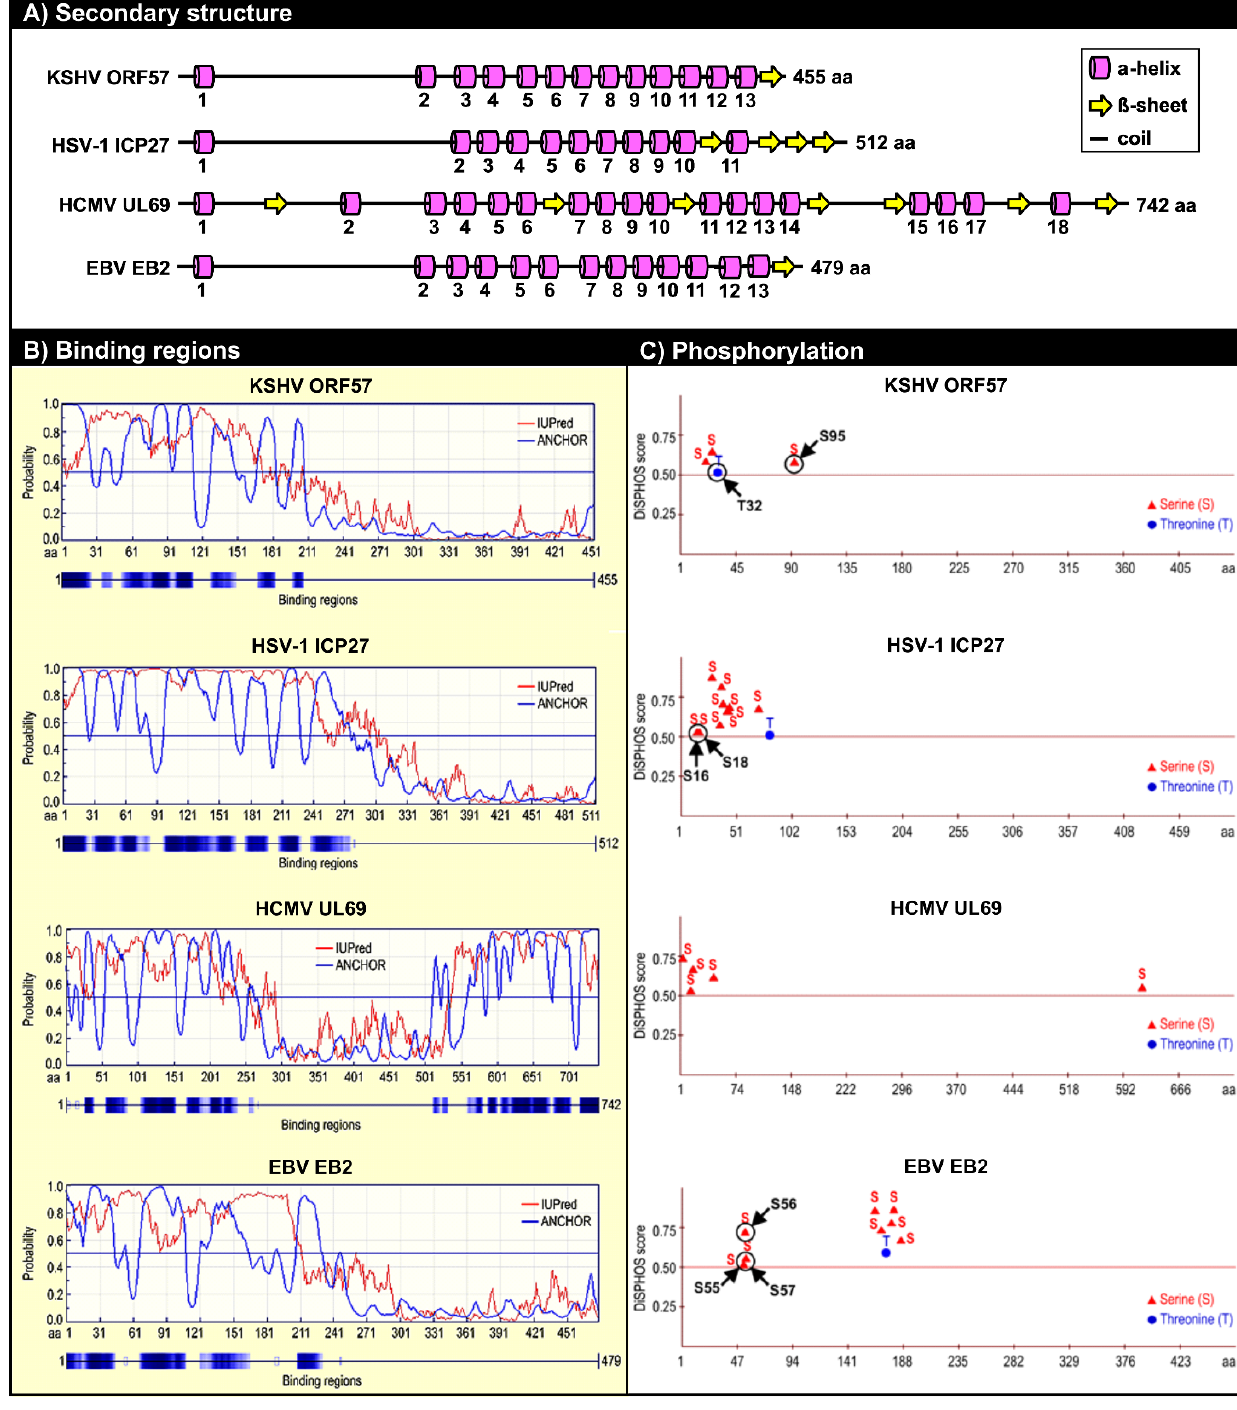
Figure 4. Structural similarities among KSHV ORF57 homologues. ( A ) Conservation of the secondary structure among KSHV ORF57 homologues: HSV-1 ICP27, HCMV UL69 and EBV EB2 based on PSIPRED version 3.0 prediction tool [95]. Numbers under each α-helix represent their relative positions from the N - to C -terminus. Numbers at the end of each protein represents the protein length in amino acid residues (aa). The drawings are not to scale. This panel is reproduced with permission from [90]; ( B ) Prediction of the disordered binding regions of KSHV ORF57, HSV-1 ICP27, HCMV UL69, and EBV EB2 both by IUPred (http://iupred.enzim.hu/) and by ANCHOR software (http://anchor.enzim.hu/)